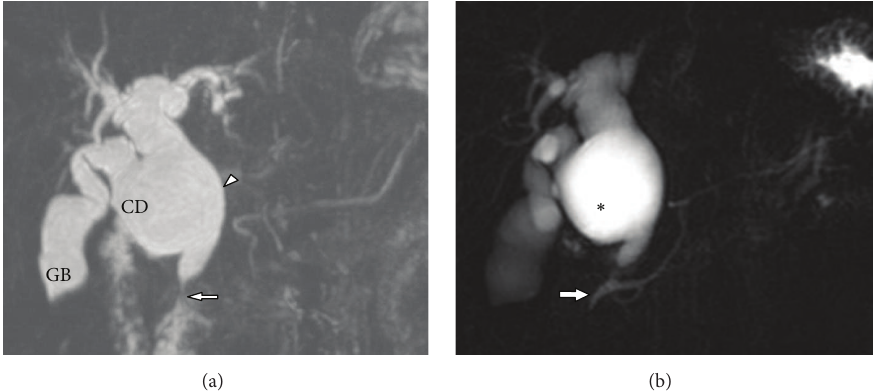
Figure 9: 42-year-old female with choledochal cyst involving the cystic duct. (a) Coronal oblique 3D MR cholangiopancreatography shows marked fusiform dilatation of the extrahepatic bile duct (white arrowhead) with abrupt tapering at distal part (white arrow). The cystic duct is elongated and tortuous and showing cystic dilatation at its distal end with wide communication with the CHD. Also note that there was fusiform dilatation of left hepatic duct. (b) Coronal oblique 3D MR cholangiopancreatography shows abnormal union of pancreatobiliary duct with long common channel. ∗ : choledochal cyst. GB: gall bladder and CD: cystic duct.